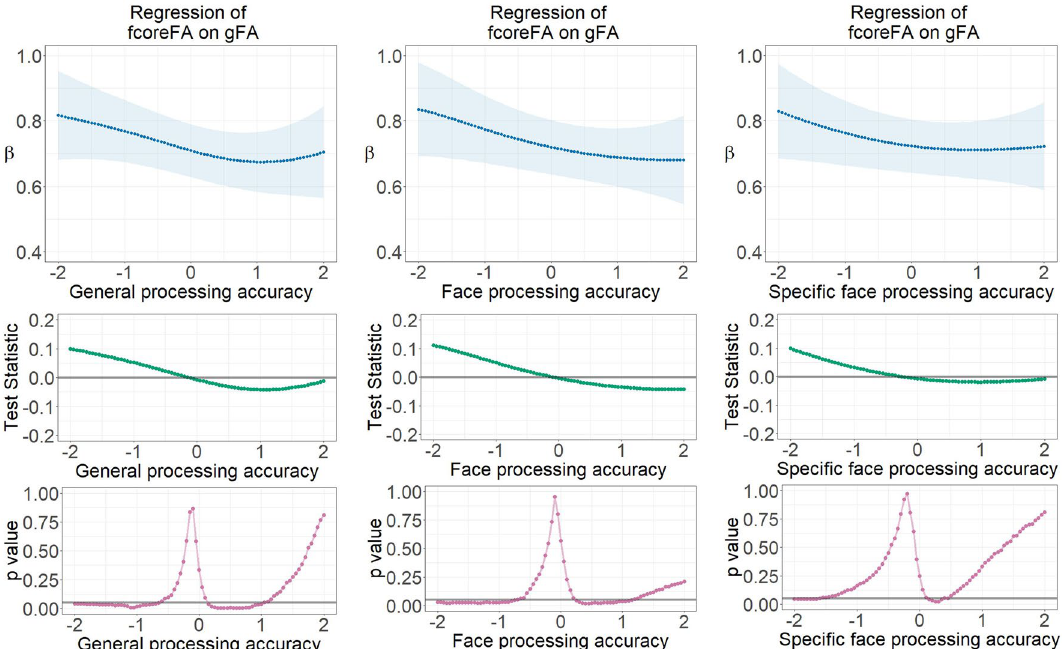
Figure 6. Parameter gradients indicating regressions of fcoreFA on gFA across continuously assessed processing accuracy ability scores using LSEM, namely (1) general processing accuracy ability, (2) face processing accuracy ability, and (3) specific face processing accuracy ability with general response accuracy controlled for. The upper row displays variations of locally estimated FA factor regression coefficients across processing accuracy scores—FA factor relationship parameter functions. The middle row provides the course of the test statistic across response accuracy scores as estimated with the permutation test. The bottom row displays the pointwise p -value curve, with p = .05 displayed as a threshold (see the gray horizontal line). β—Standardized latent regression weight; gFA—Fractional anisotropy in global brain fibers; fcoreFA—Fractional anisotropy of core face network